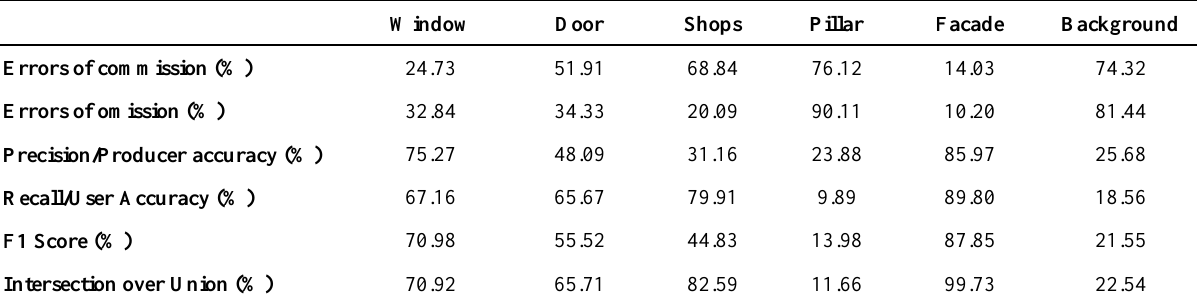
Table 2. Statistics derived from the result of the semantic